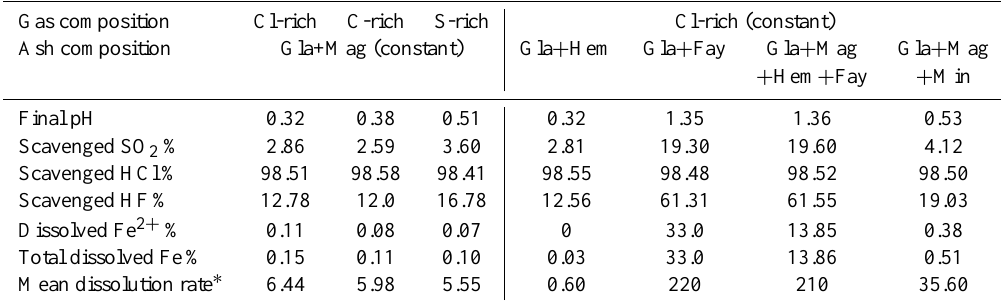
Table 5. Sensitivity of the key iron mobilization parameters to the changes in the volcanic gas (left panel) and ash (right panel) composition. The first column from left is the reference scenario having Cl-rich as the gas and Gla+Mag as the ash composition. Gas composition Cl-rich C-rich S-rich Cl-rich (constant) Ash composition Gla+Mag (constant) Gla + Hem Gla + Fay Gla + Mag Gla + Mag + Hem + Fay + Min Final pH